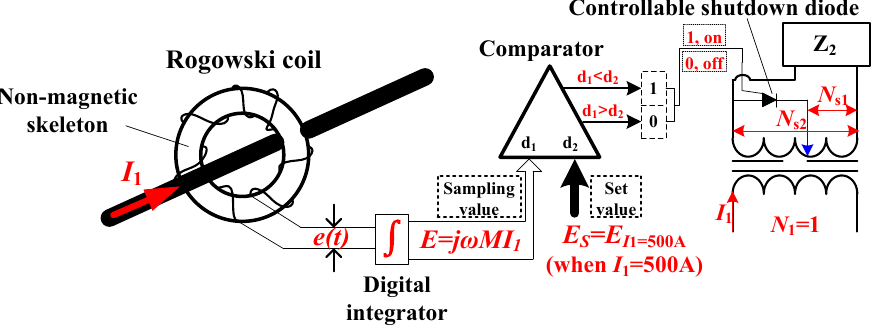
Figure 8. The control strategy of power stability.